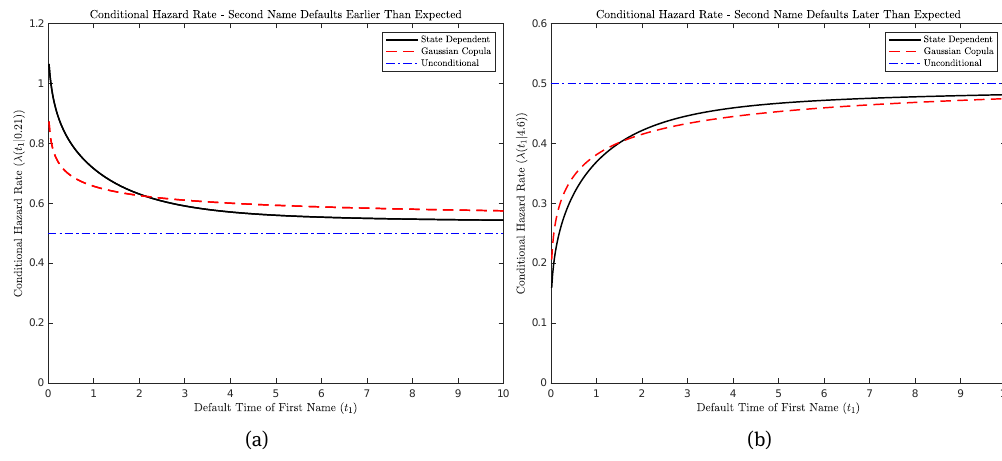
Figure 6.2: This figure illustrates the conditional hazard function of T 1 , given that T 2 = t 2 , assuming that both T 1 and T 2 are exponentially distributed with rate λ = 0.5 (other parameter values are as in Figure 6.1). The conditional hazard function is defined in (6.3) , and we compute it using (6.5) . The solid line corresponds to the proposed model, the dashed line corresponds to the Gaussian copula model and the dash-dot line corresponds to the unconditional hazard rate (which is the same in both models). Panel (a) corresponds to the case where the second name defaults much earlier than expected, in the sense that the realized value of T 2 is equal to the 10 th percentile of its marginal distribution (i.e. it depicts λ ( t 1 | 0.21) ). Panel (b) corresponds to the case where the second name defaults much later than expected, in the sense that the realized value of T 2 is equal to the 90 th percentile of its marginal distribution (i.e. it depicts λ ( t 1 | 4.61)